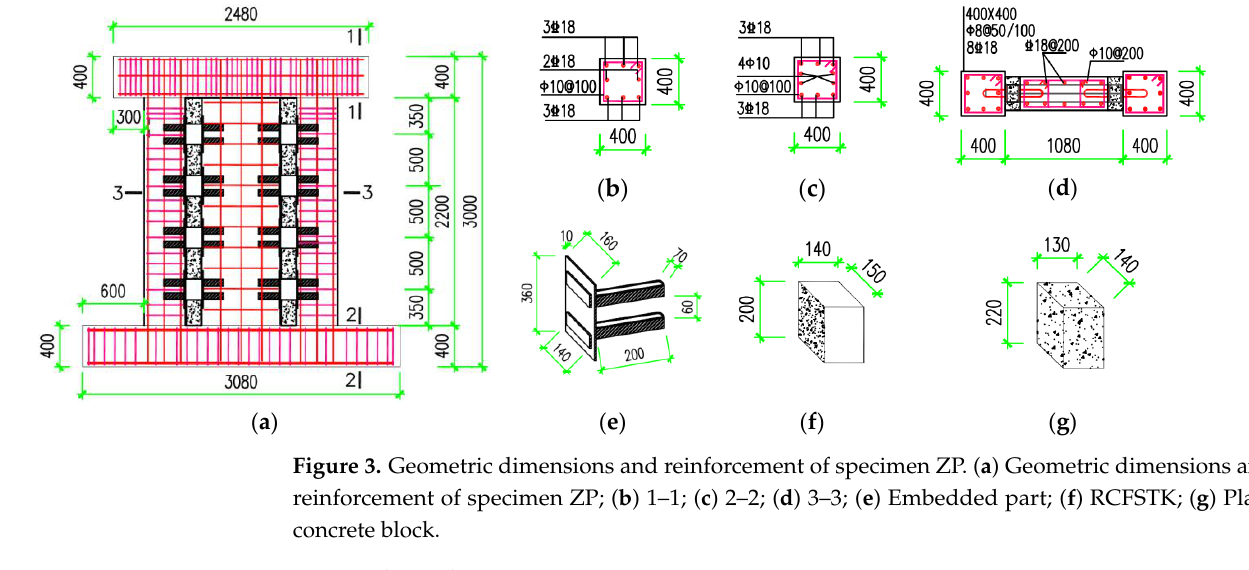
Figure 3. Geometric dimensions and reinforcement of specimen ZP. ( a ) Geometric dimensions and reinforcement of specimen ZP; ( b ) 1 – 1; ( c ) 2 – 2; ( d ) 3 – 3; ( e ) Embedded part; ( f ) RCFSTK; ( g ) Plain concrete block.